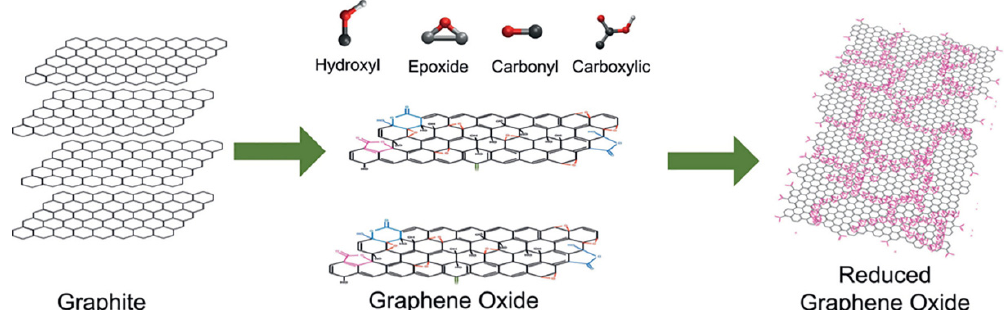
Figure 2. Schematic representation of the structure of graphene oxide and reduced graphene oxide showing functional groups at the edges. Reproduced with permission from Bonaccorso et al., Mater. Today; published by Elsevier, 2012 [83] .